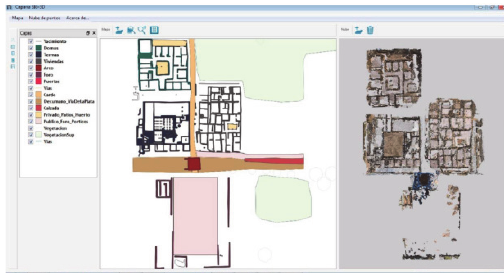
Figure 9. Graphical interface of the hybrid